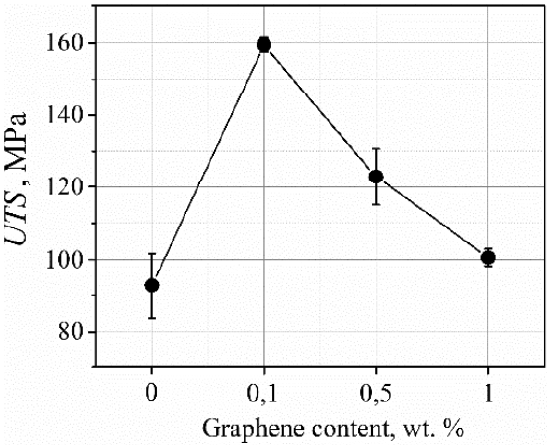
Fig. 8. The effect of TEG addition in the initial pow- der mixture on ultimate tensile strength obtained for Specimens